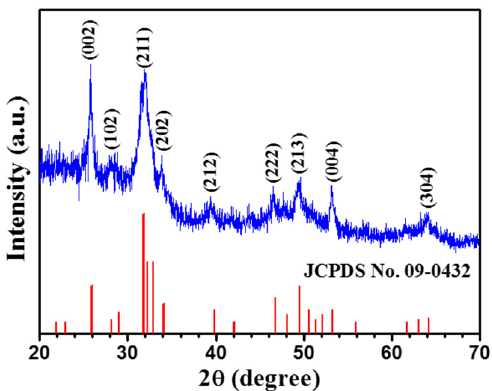
Figure 11. Typical XRD pattern from the β -Ta coating after exposure to Hank’s solution for seven days. Diffraction peaks for hydroxyapatite (JCPDS # 09-0432) are shown for reference.